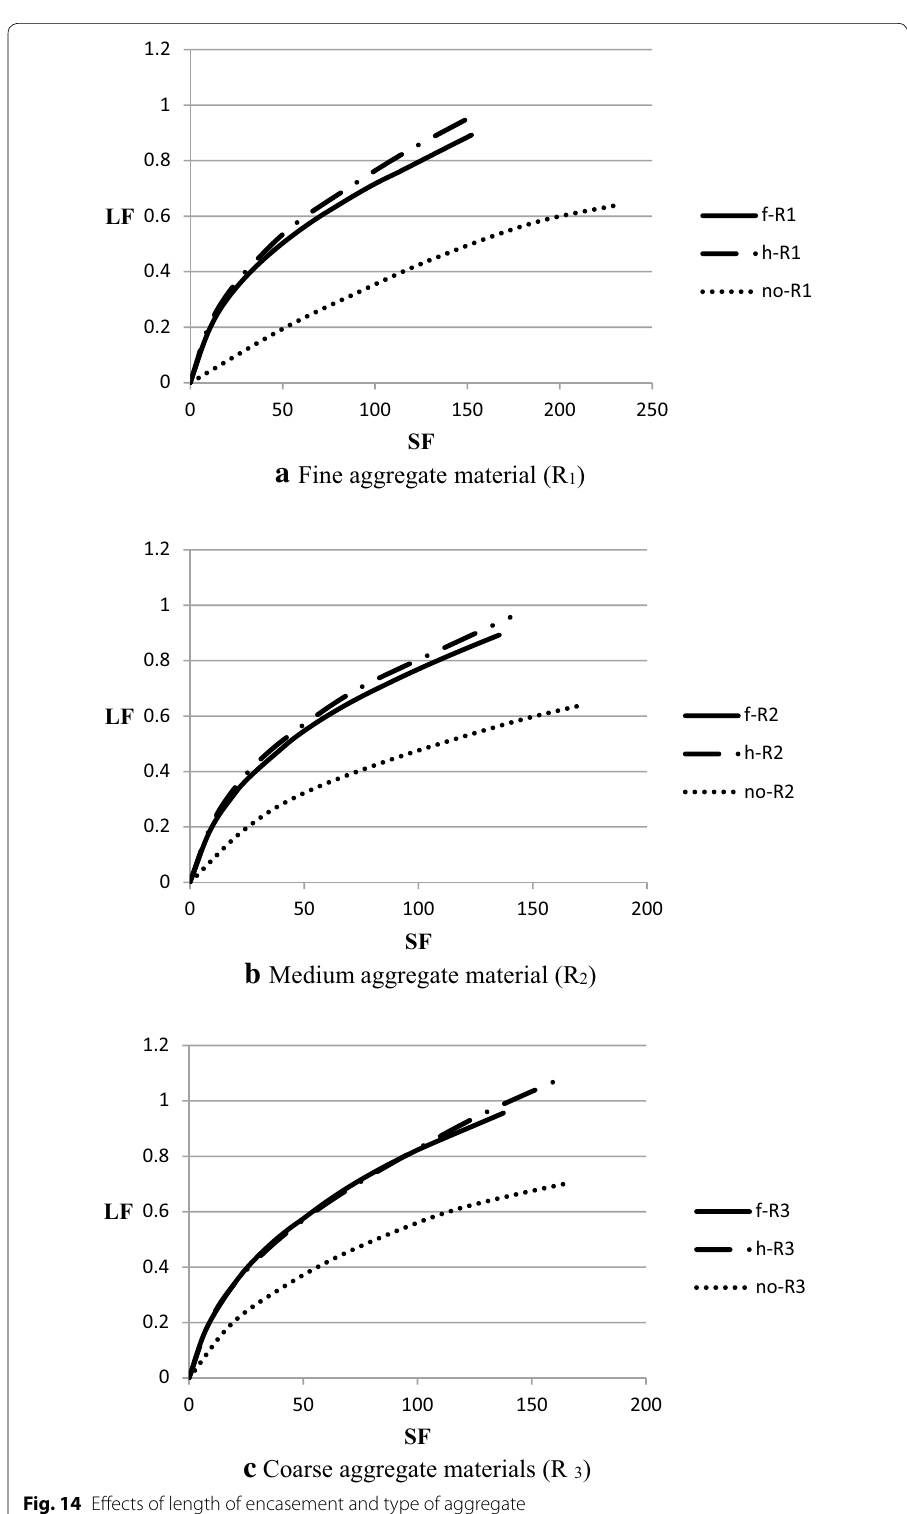
Fig. 14 Effects of length of encasement and type of